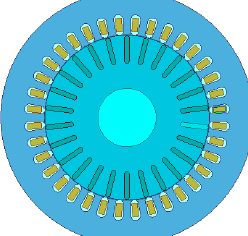
Figure 2. Modeling of the induction motor using FEM.